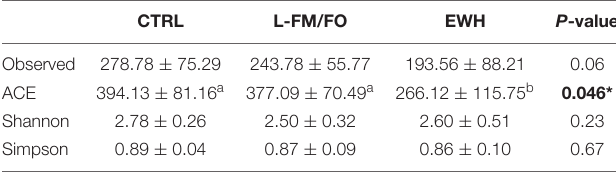
Values are mean ± SEM of 9 fish. Asterisk (*) and bold font indicates significant differences among groups (Holm–Sidak, P < 0.05) denoted by different superscript